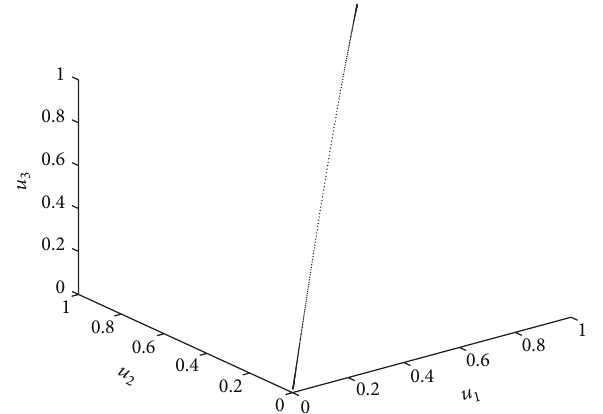
Figure 3: 3D computer simulation result shows simple dynamical behaviors of the uncontrolled system (6) in the (𝑢 1 , 𝑢 2 ,𝑢 3 ) space for 𝑘 = 2 , and 𝑛 from 0 to 20000, with the initial condition 𝑢(0) = (0.01, 0.01, 0.01) 𝑇 .